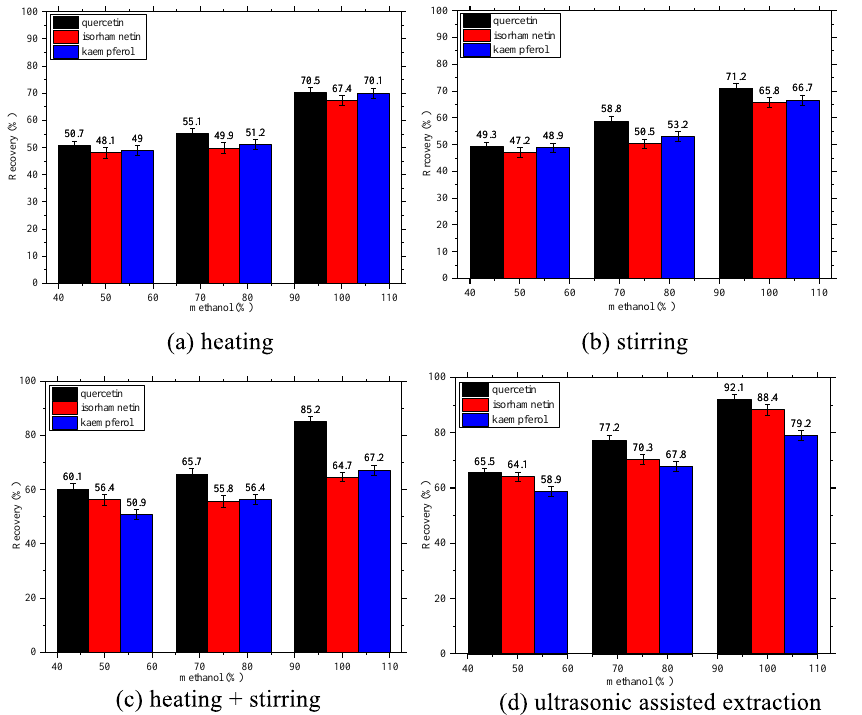
Figure 3. Selection of the extraction method and solvent.